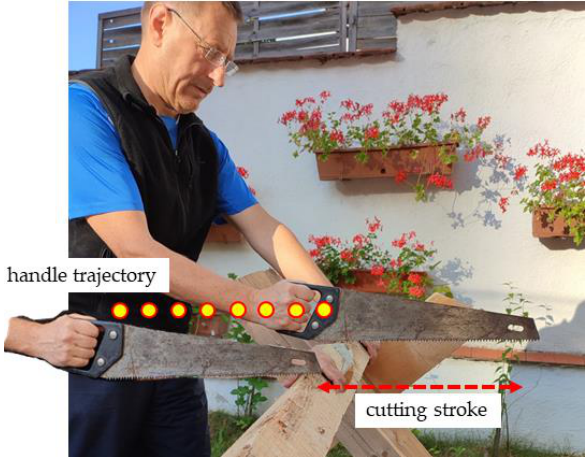
Figure 1. User study for trajectory estimation of the handle of the saw while cutting a